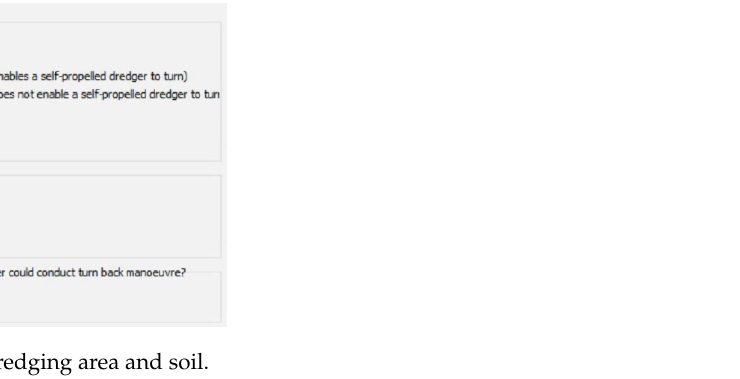
Figure 5. Dredger selection. 2.4. Module for the Analytic Hierarchy Process (AHP) as a Method of Support for the Decision- Making Process within the Collection of Dredgers While AHP can be used in many decision-making troubles, AHP is conventionally used in collection, ranking, along with predicting. AHP supposes that the decision-makers recognise or will come up with independently or jointly, indirectly otherwise unambigu- ously, the conditions or purposes as well as the substitutions related with the assessment. AHP is also especially valuable for states in which we have together noticeable and inde- finable conditions to reflect in the conclusion. The use of the AHP method in the model is the final specification for selecting a par- ticular dredger among several dredgers currently available on the market with the re- quired technical parameters. While the AHP is amongst the most progressive approaches available in managing knowledge and processes exploration, the complexity concerned in using this instrument formulates it as problematic to operate. Appreciatively implemented software devices